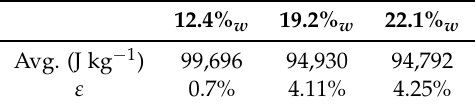
Figure 11. Comparisons of the enthalpy functions obtained with minimal (blue) and maximal (red) values of the identified parameters, together with the absolute discrepancy, for all the mortars ( n.b. unique formulation pertaining for both fusion and crystallization). Table 5. Estimated values of the micronal latent heat and comparison with the experimental value obtained by DSC